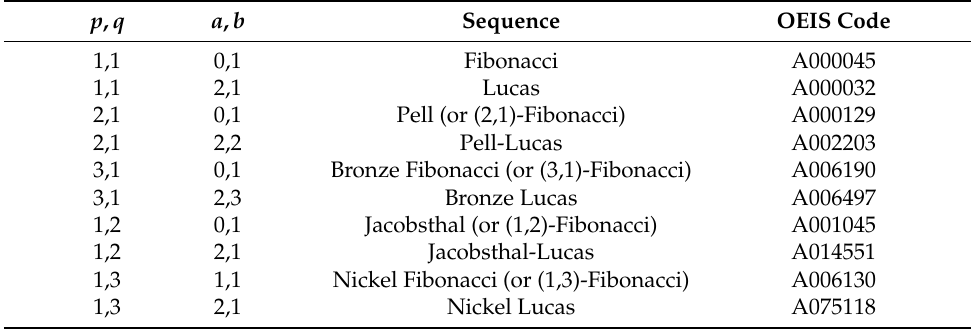
Table 1. Some subsequences of the Horadam numbers with OEIS